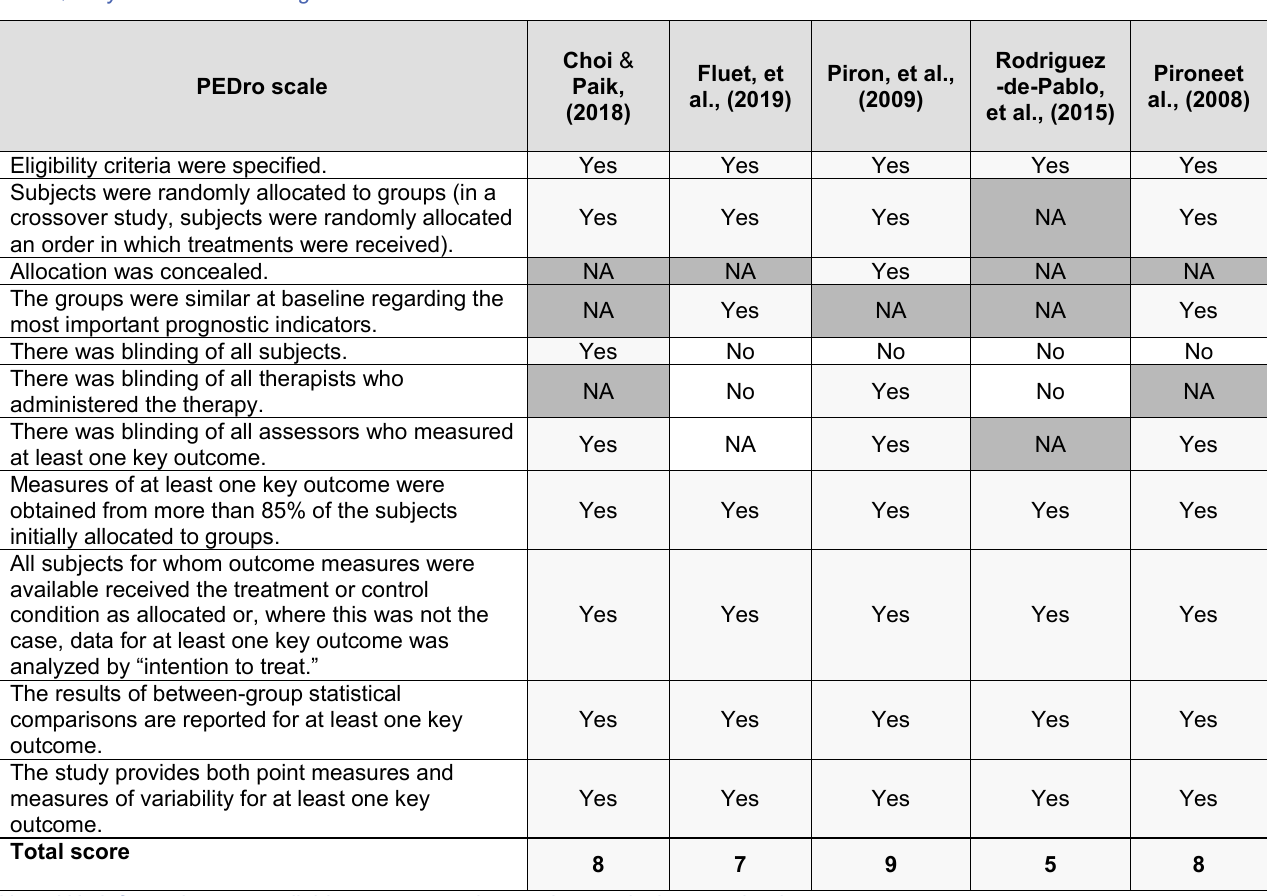
Table 3 RCT Quality Assessment Using PEDro